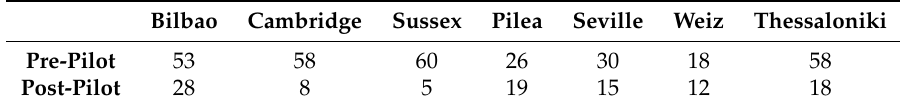
Table 4. Number of responses per GreenSoul